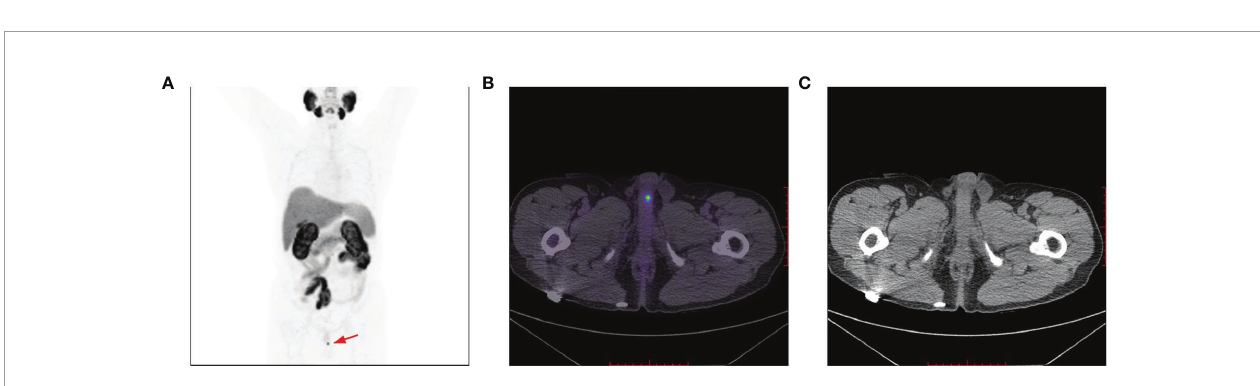
FIGURE 4 | A 18 F-PSMA-1007 PET/CT avid solitary penile lesion with a SUV max of 6.4 (A, B) ; no morphological abnormalities of the penis detected on CT imaging (C)